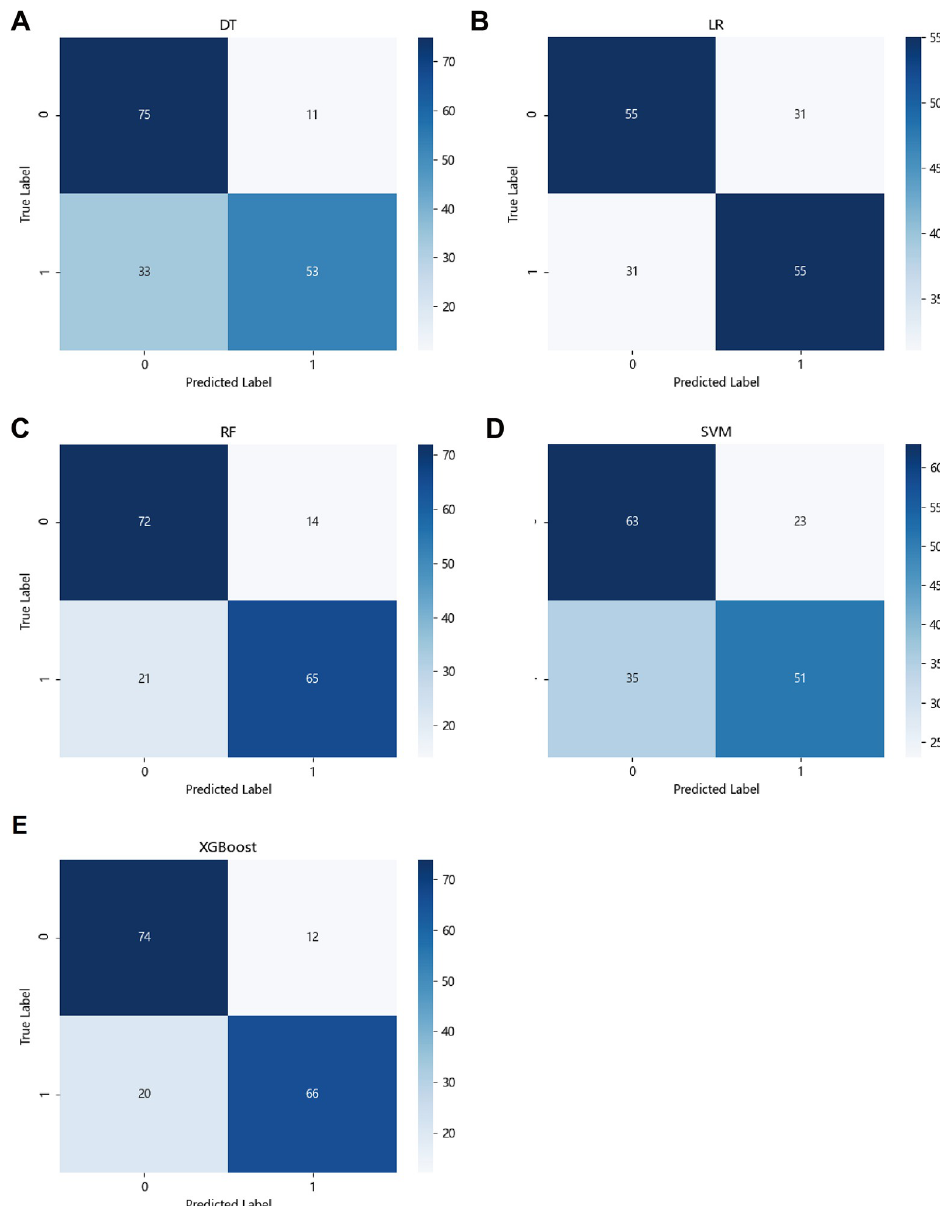
Fig 2. Confusion matrix of the risk prediction models with machine learning algorithms. (A) DT: decision tree. (B) RF: random forest. (C) LR: logistic regression. (D) SVM: support vector machine. (E) XGBoost: extreme gradient